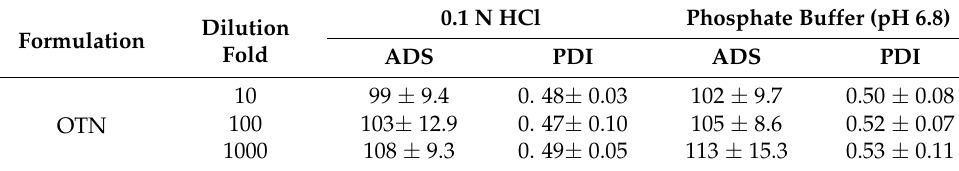
Figure 5. Nano-emulsion stability evaluation of the optimized tadalafil formulation; ( A ) changes in average droplet size (ADS) and ( B ) changes in polydispersity index (PDI). Table 7. Effect of dilution on the optimized tadalafil NE (OTN) characteristics.